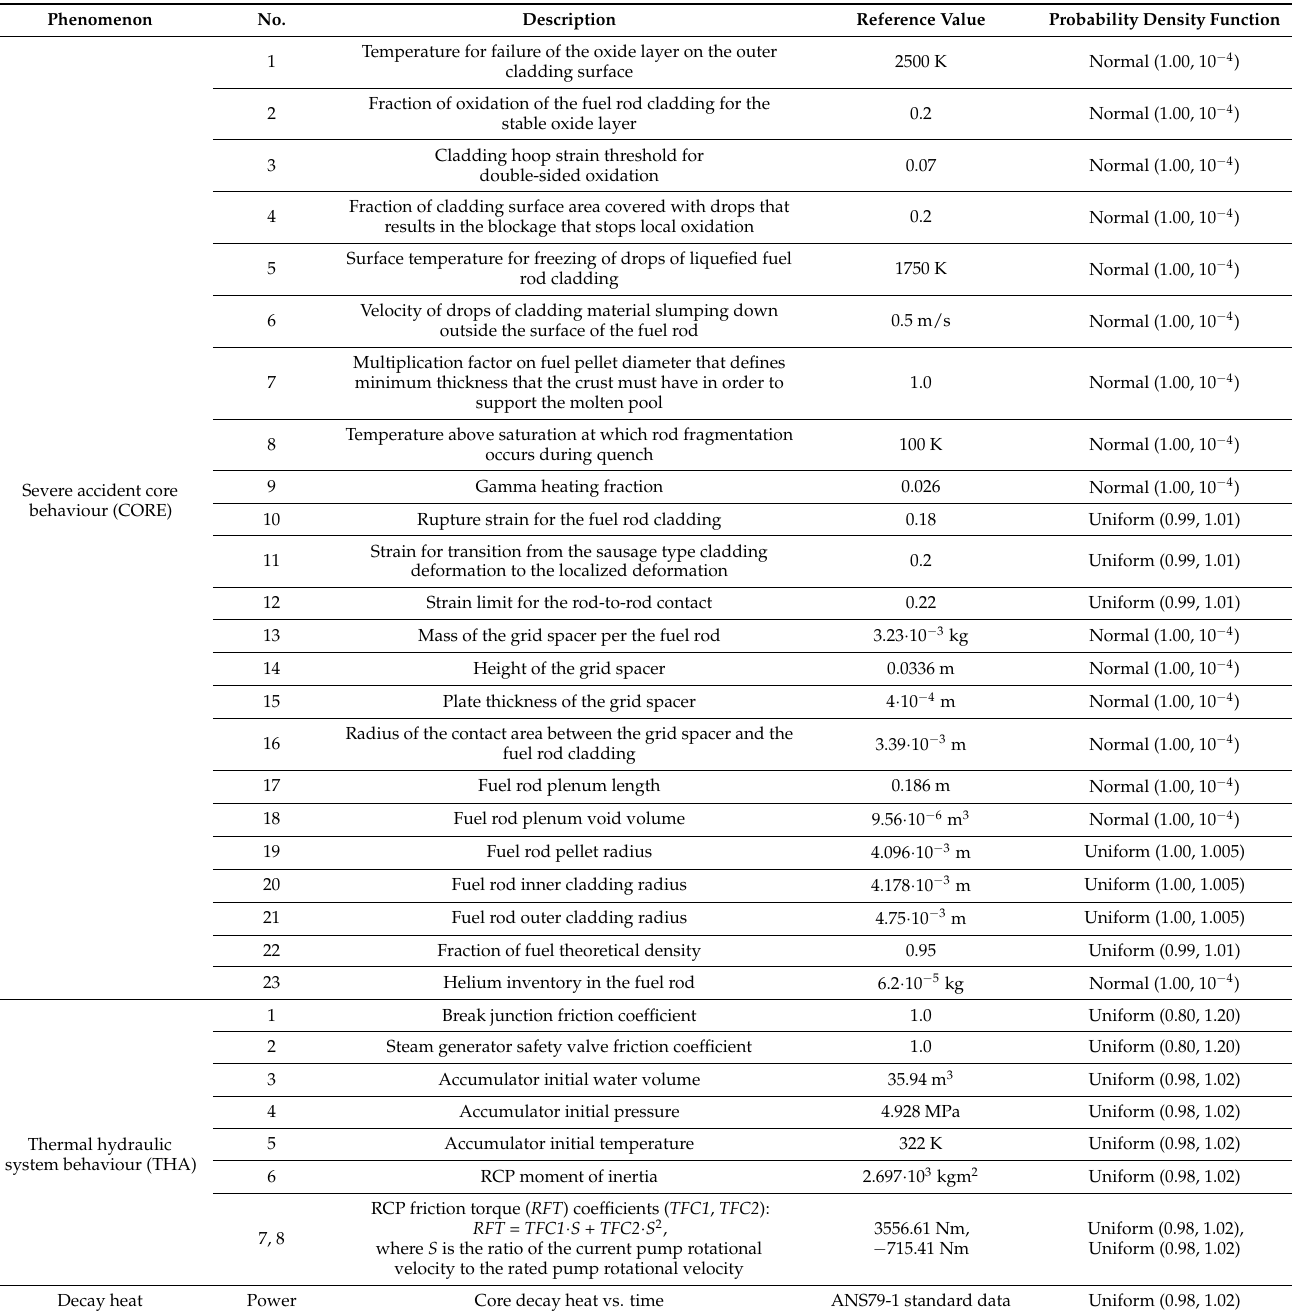
Table 1. Input uncertain